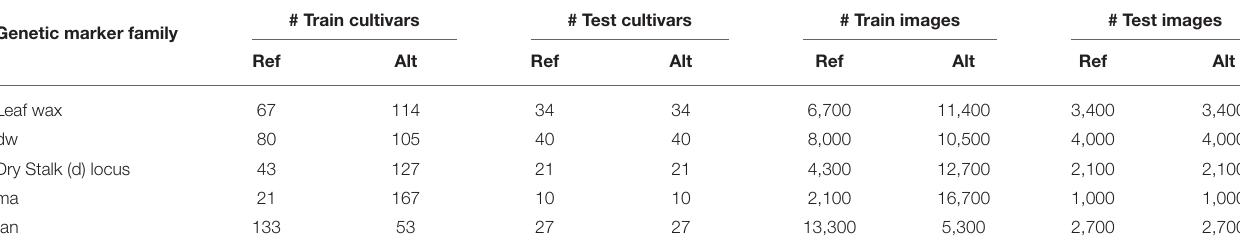
TABLE 2 | Dataset statistics. Genetic marker